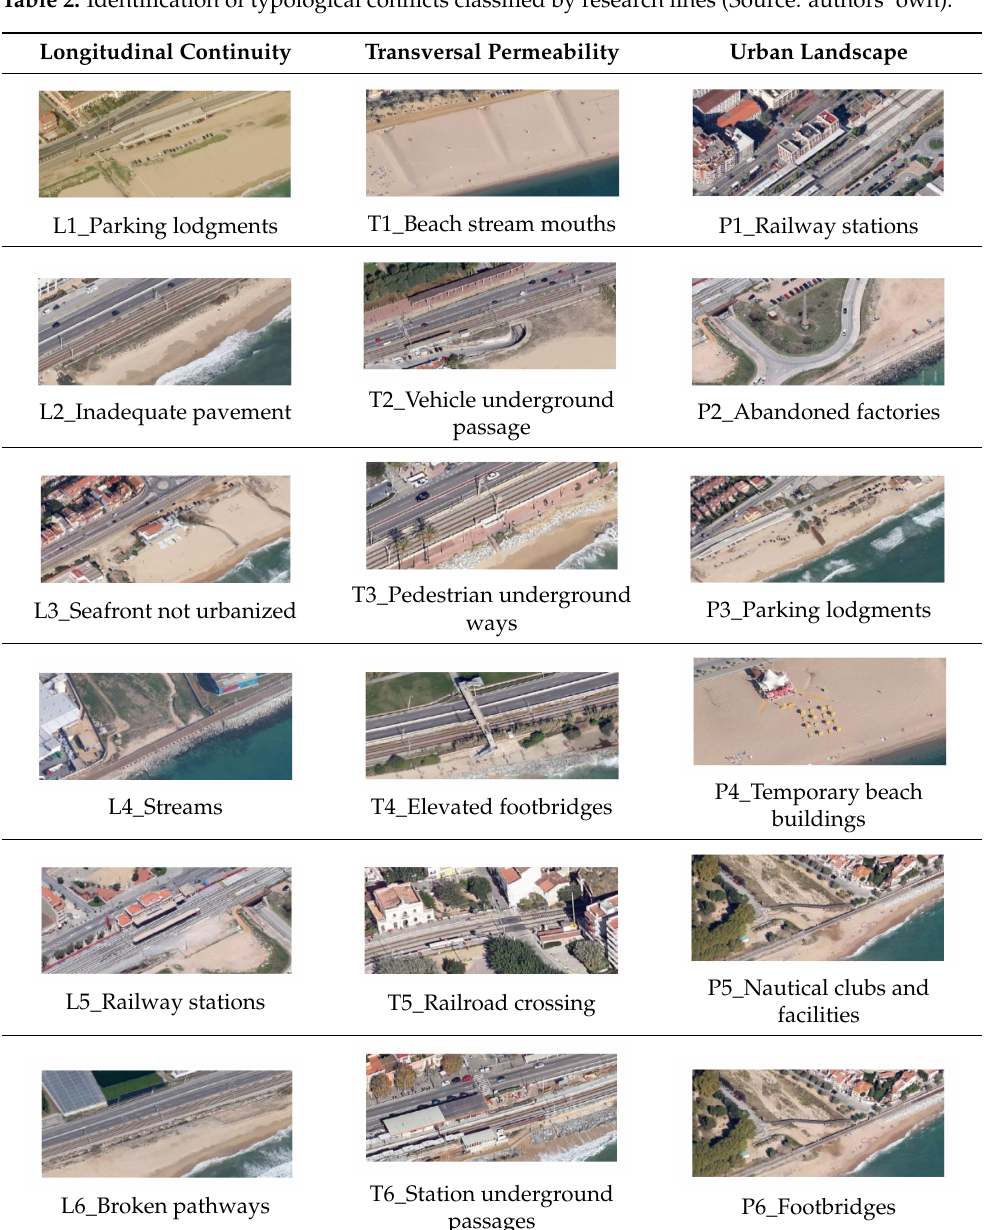
Table 2. Identification of typological conflicts classified by research lines (Source: authors’